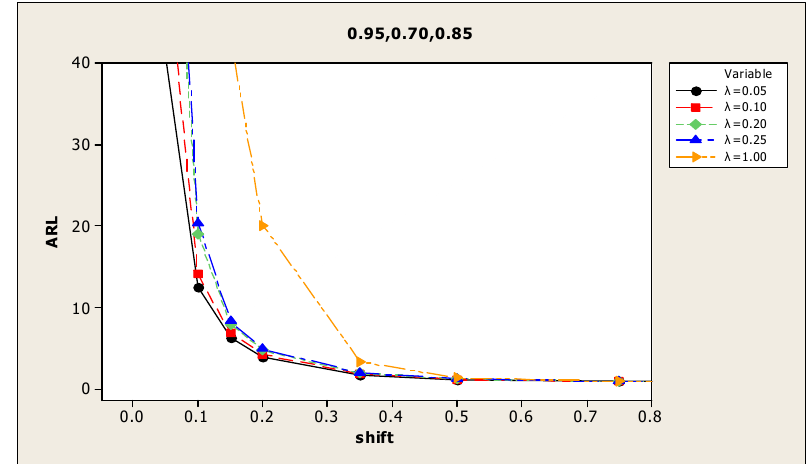
Figure 14. ARL curves when ρ yu = 0.95, ρ yv = 0.7, ρ uv = 0.85 at above values of λ